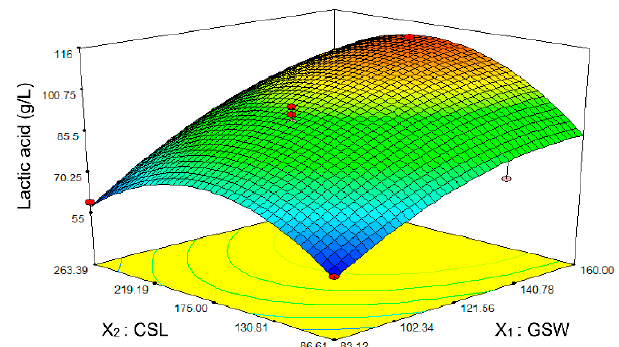
Figure 2. The three-dimensional response surface plot demonstrates the effects of CSL and GSW on lactic acid production by L. plantarum S21 at 37 °C after 24 h fermentation.